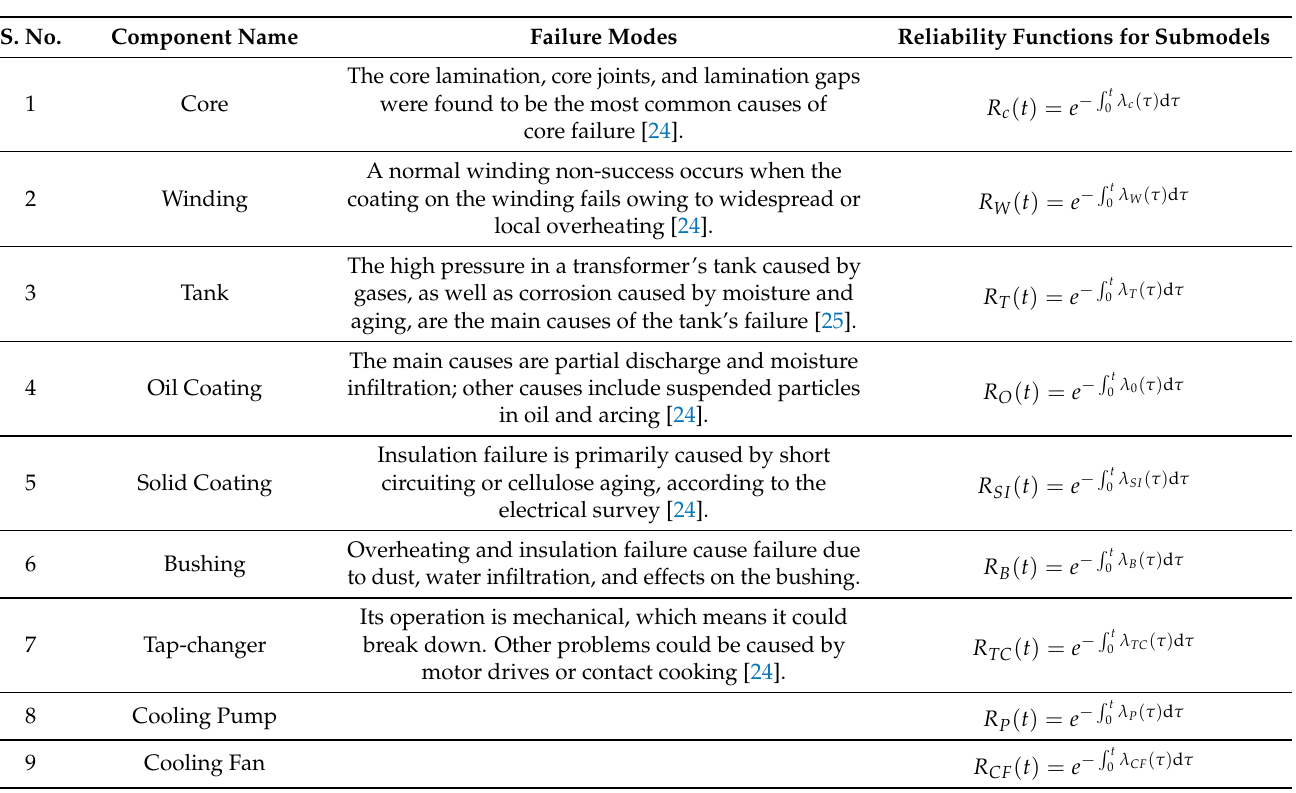
Table 1. Reliability submodels of